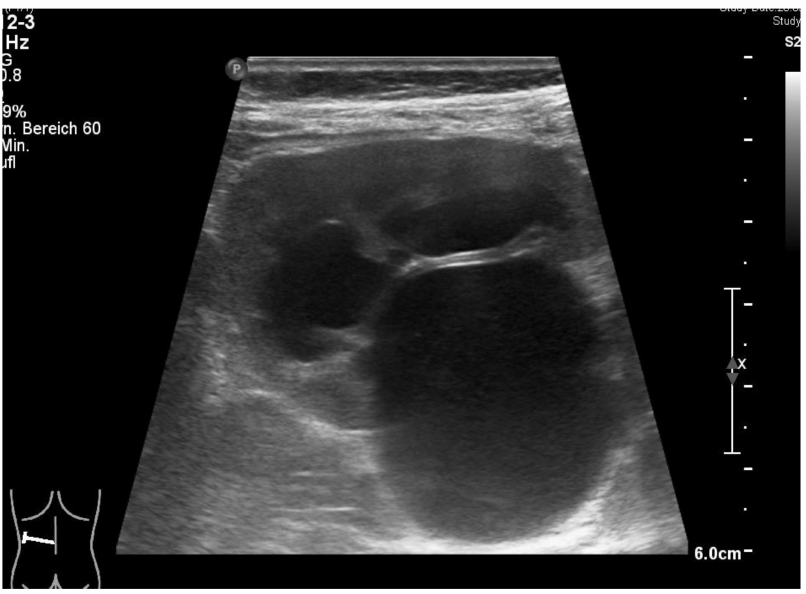
Figure 1. Ultrasound test of 1.5-year-old girl (19 May 2020) presenting with recurrent febrile urinary tract infections shows dilatation of the pyelon and hydronephrosis of the left kidney (courtesy of Dr. A. Longin, Klinikum Esslingen).